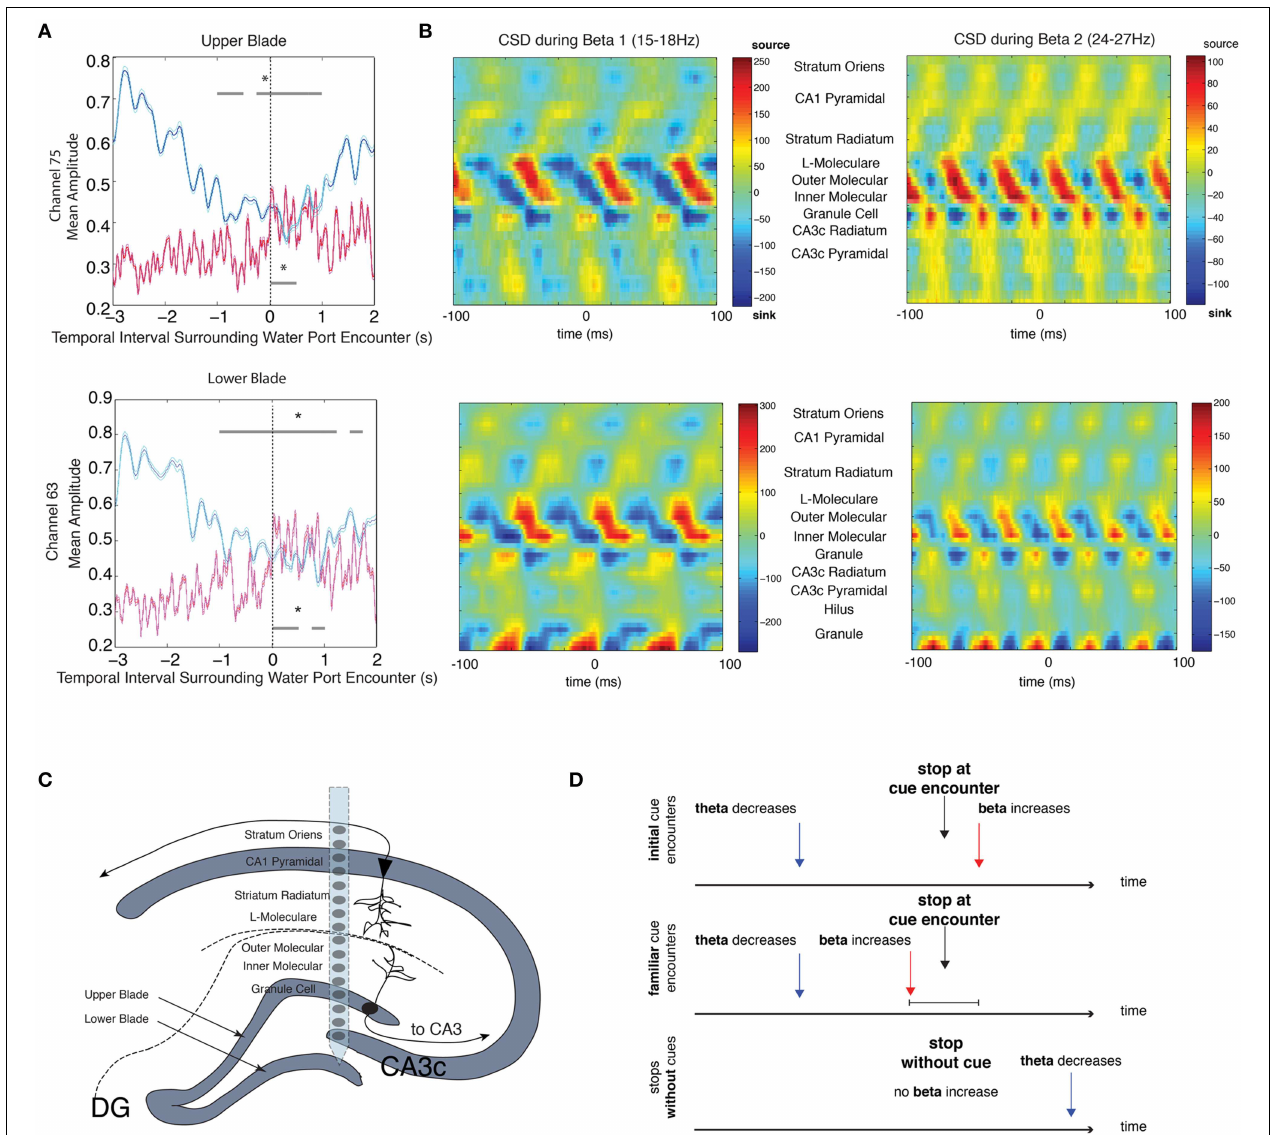
FIGURE 5 | CSD analysis of beta local field potentials along the D/V Axis. (A) Mean theta ( blue ) and mean beta ( red ) amplitude for intervals surrounding stops at the water port for a single session (top: upper blade of the granule cell layer, bottom: lower blade of the granule cell layer). The upper gray bar indicates 250ms bins with significant decreases in theta amplitude ( blue ) and the lower gray bar indicates 250ms bins with significant increases in beta amplitude ( red ). Error bars indicate standard error for theta ( cyan ) and beta ( magenta ) means. (B) Average CSD (current source density) from one rat for the 200ms surrounding the trough of each beta cycle that met the following conditions: (1) cycle occurred within the 5s intervals surrounding stops at the water port and (2) beta amplitude was 2 STD above the mean